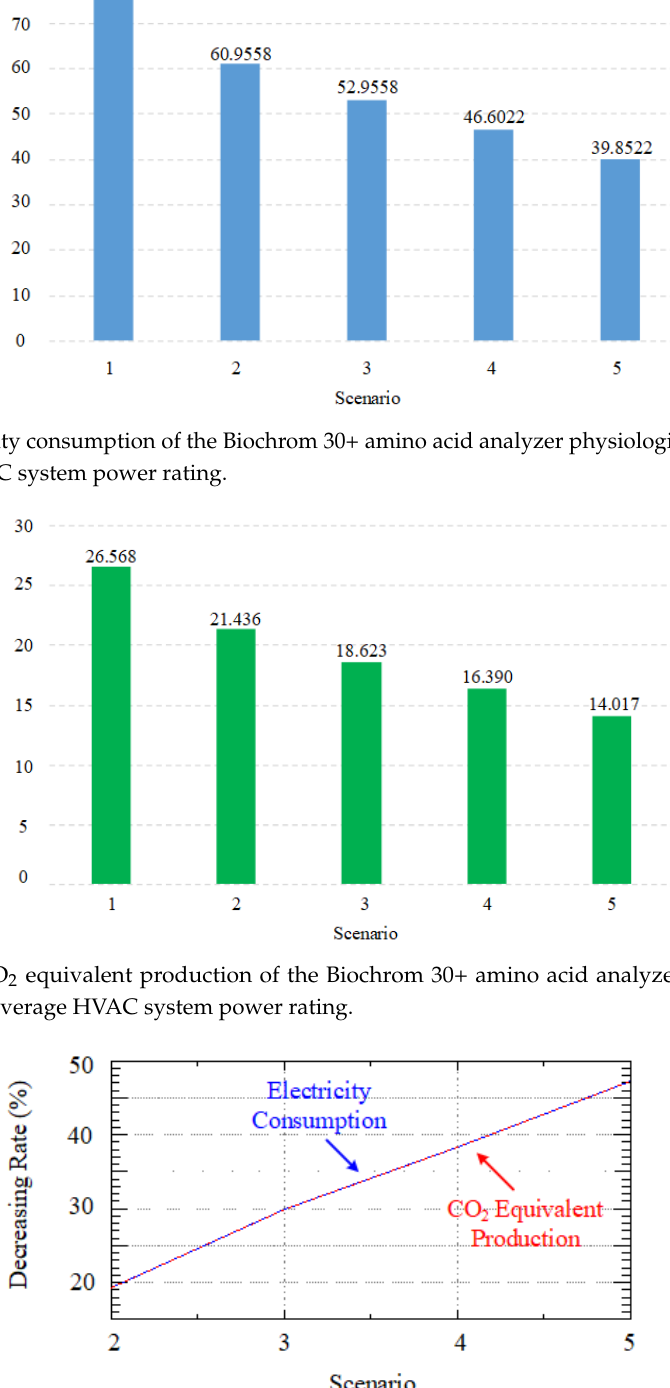
Figure 4. Decreasing rates of electricity consumption and CO 2 equivalent production for different scenarios to scenario 1.